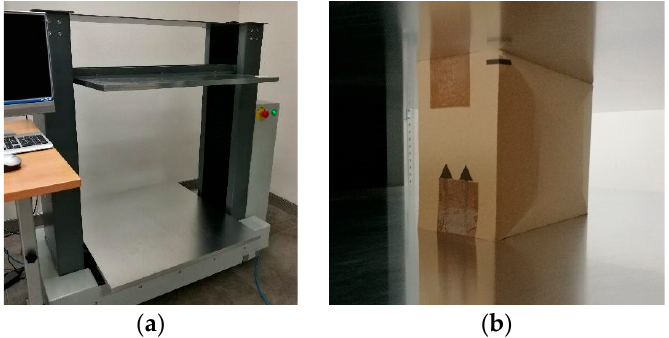
Figure 3. BCT tests: ( a ) BCT press; ( b ) packaging with the shifted offsets on the flaps.